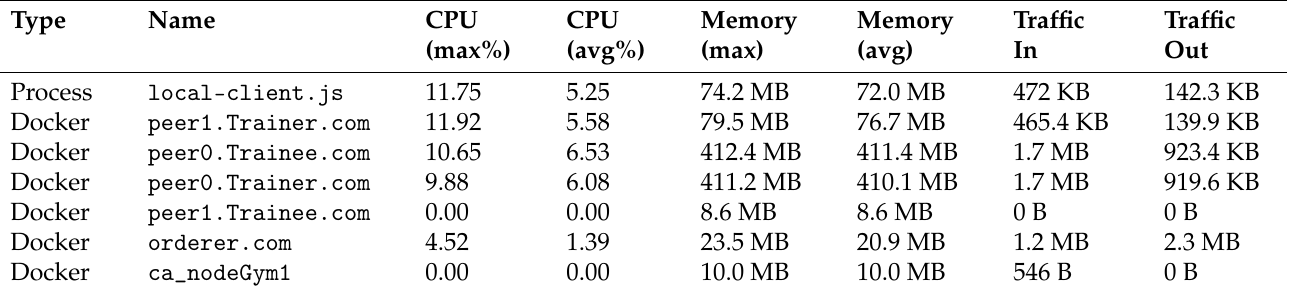
Table 12. Resource Utilization Analysis of Proposed